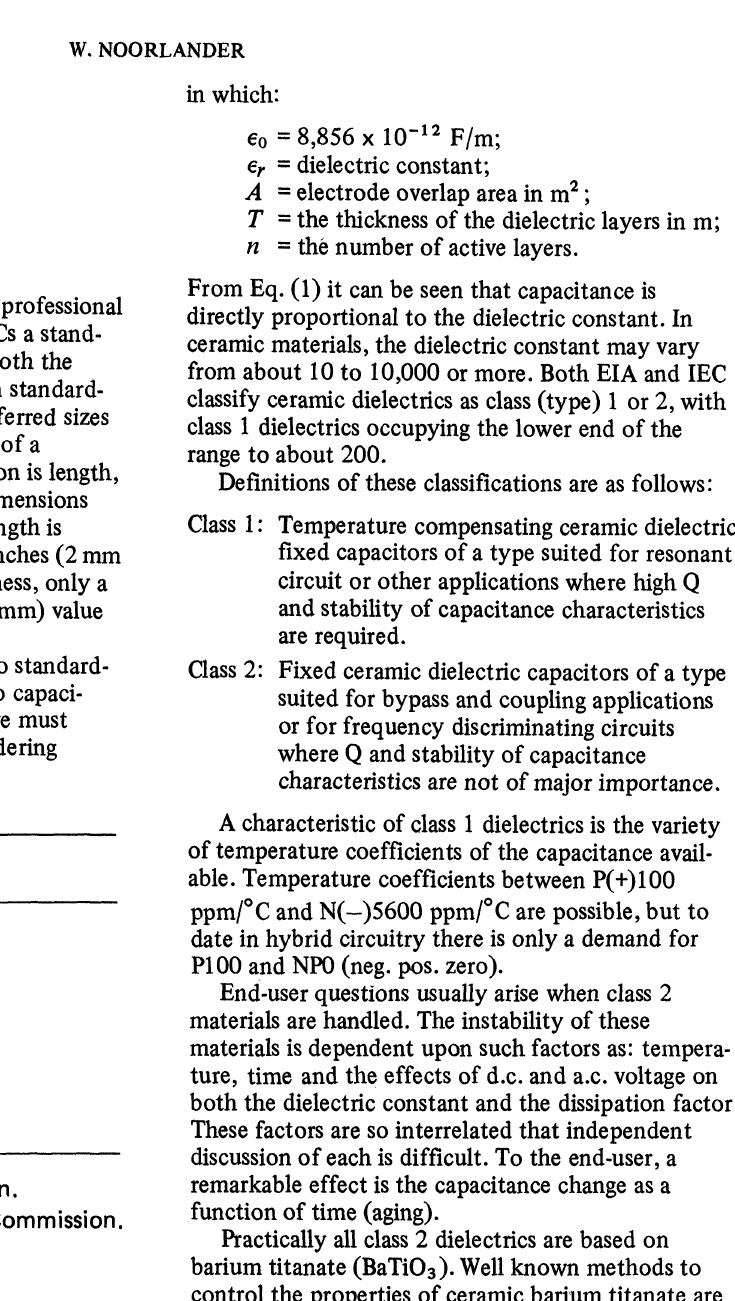
FIGURE 2 Preferred MCCC